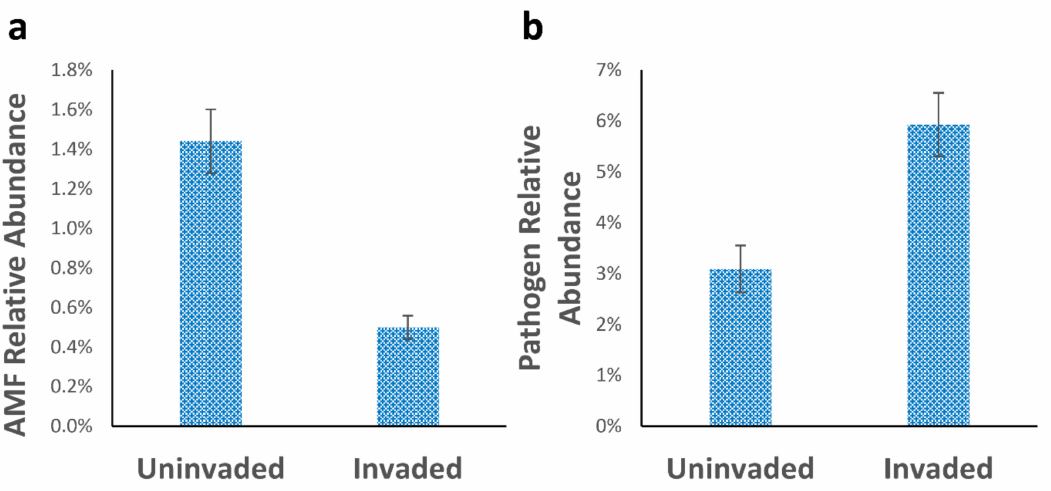
Figure 4. Di ff erences between high level functional groups: ( a ) arbuscular mycorrhiza ( p < 0.001); ( b ) pathogens ( p = 0.003) on the basis of ANOVA ( n = 25 per site). Error bars represent SEM (standard error of